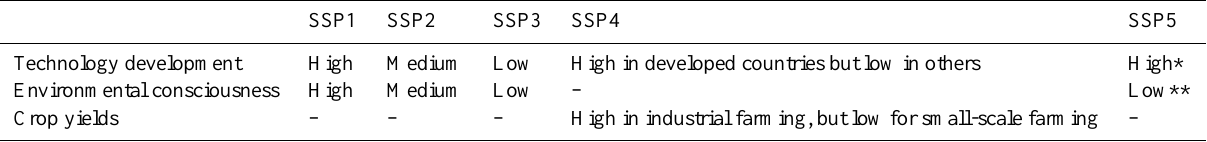
Table 1. Summary of the narrative scenarios of the SSPs.